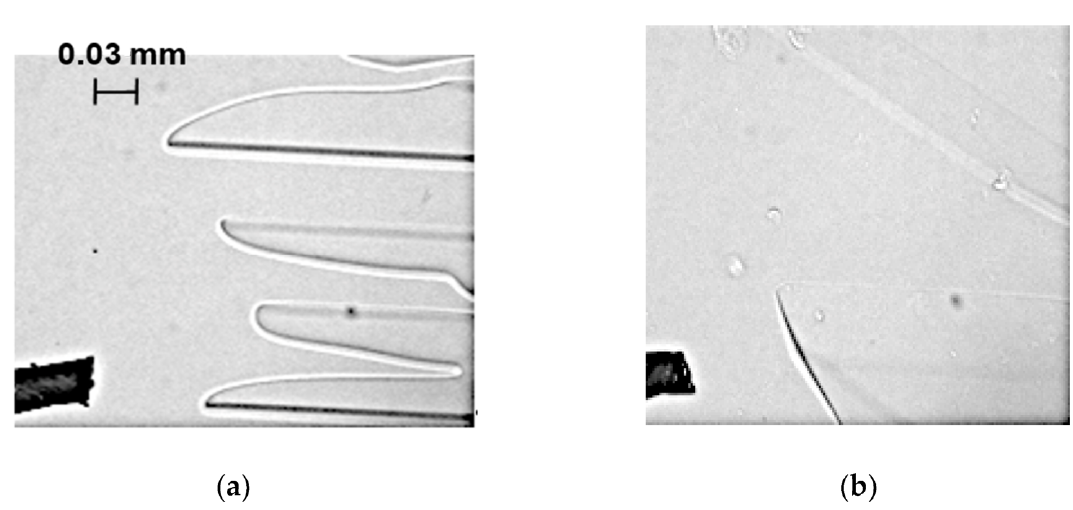
Figure A1. Typical images of ice/solution interfaces: ( a ) salt solution and ( b ) mixed solution. The black areas show the shadows of micro thermocouples.